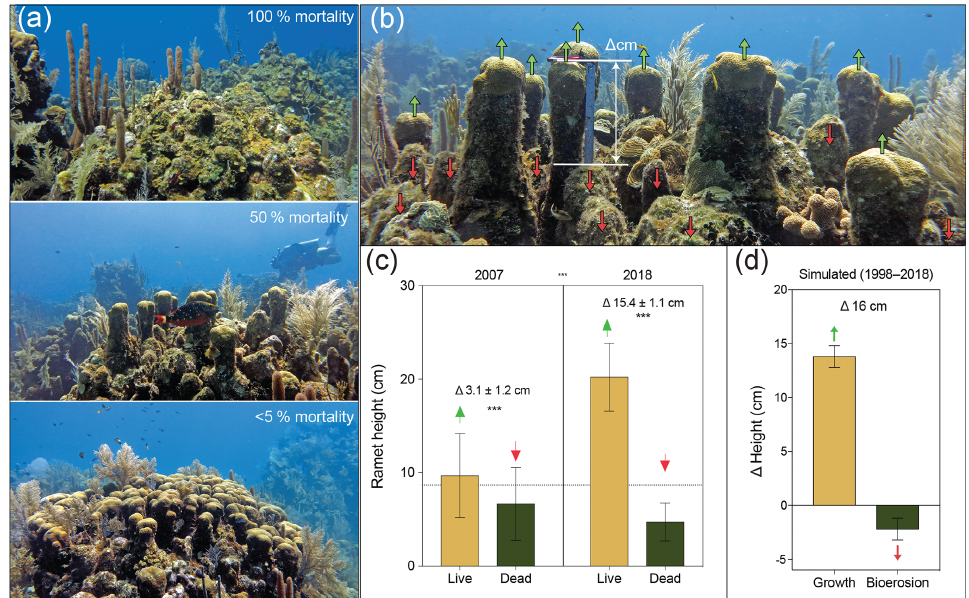
Figure 2. (a) Orbicella annularis colonies from Long Caye in 2018, indicating high survival following the mass bleaching event ( < 5% mortality), complete (100%) mortality followed by algal overgrowth by Lobophora variegata , and partial mortality ( ∼ 50%) resulting in a characteristic “serrated” pattern and gaps. (b) The O. annularis framework at Long Caye in 2007, showing the growth of surviving ramets (green arrows) protruding above the eroding dead ramets (red arrows) and the difference in height between live and dead ramets (scale ruler is equal to 15cm). (c) The height of “live” and “dead” ramet pairings in 2007 and 2018, showing a significant difference in height within years and a significant difference in the average height of live ramets within years ( ∗∗∗ denotes p < 0 . 001). (d) Simulated growth and bioerosion between 1998 and 2018 based upon a linear erosion rate of 0 . 11 ± 0 . 03cmyr − 1 and a growth rate of 0 . 69 ± 0 . 1cmyr − 1 (Roff et al.,